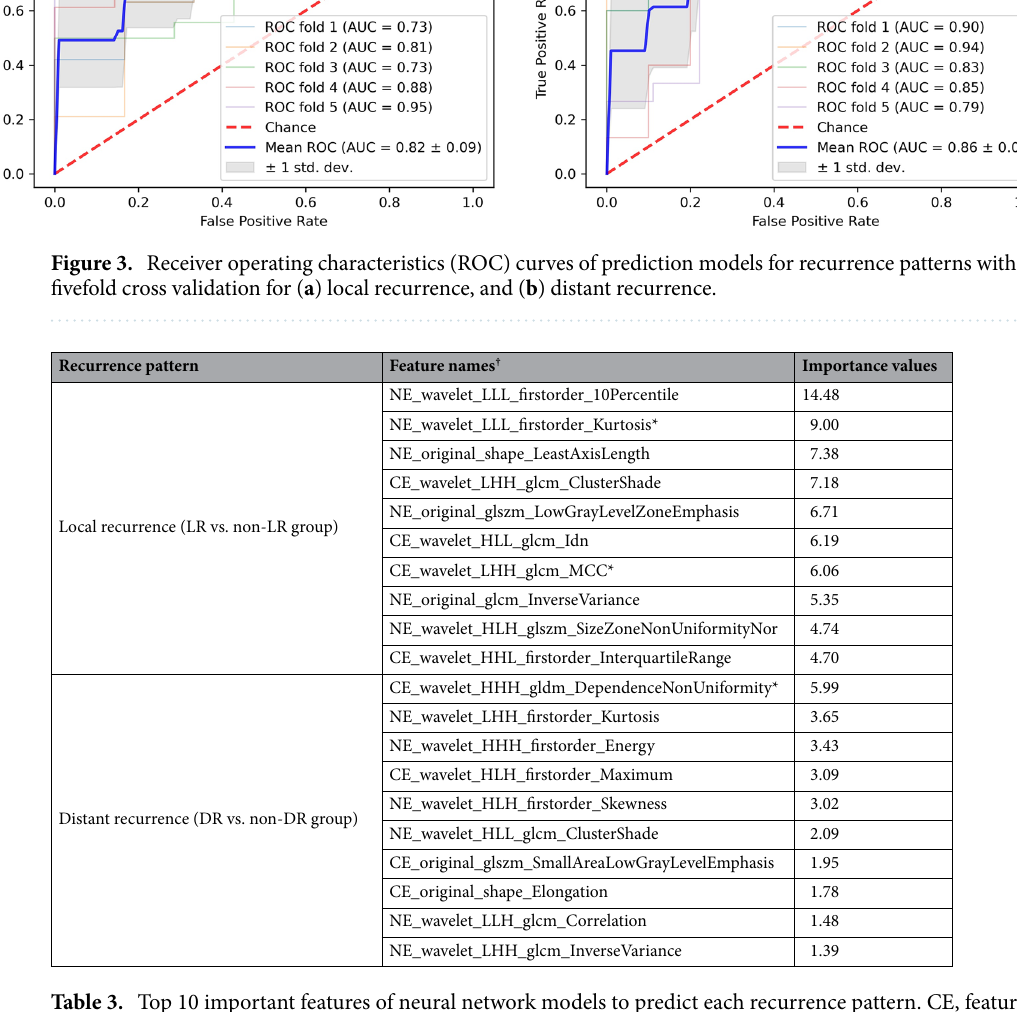
Table 3. Top 10 important features of neural network models to predict each recurrence pattern. CE, features from T1-weighted contrast-enhanced images; NE, features from non-enhancing T2 high signal intensity